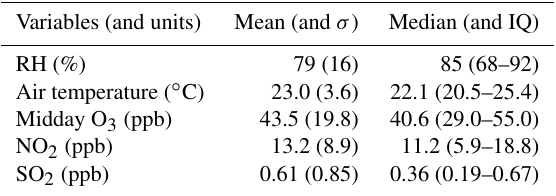
Table 1. Summarized statistics of meteorological data and mixing ratios of trace gases from 20 December 2016 to 15 March 2017. Statistics includes mean concentration, SD ( σ ), median, and in- terquartile interval